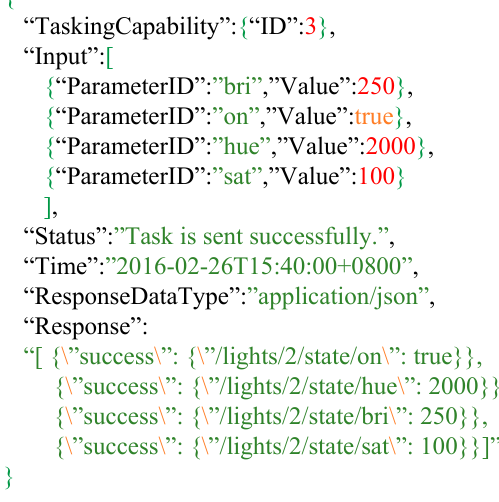
Figure 14. A Task entity example for controlling Philips Hue.